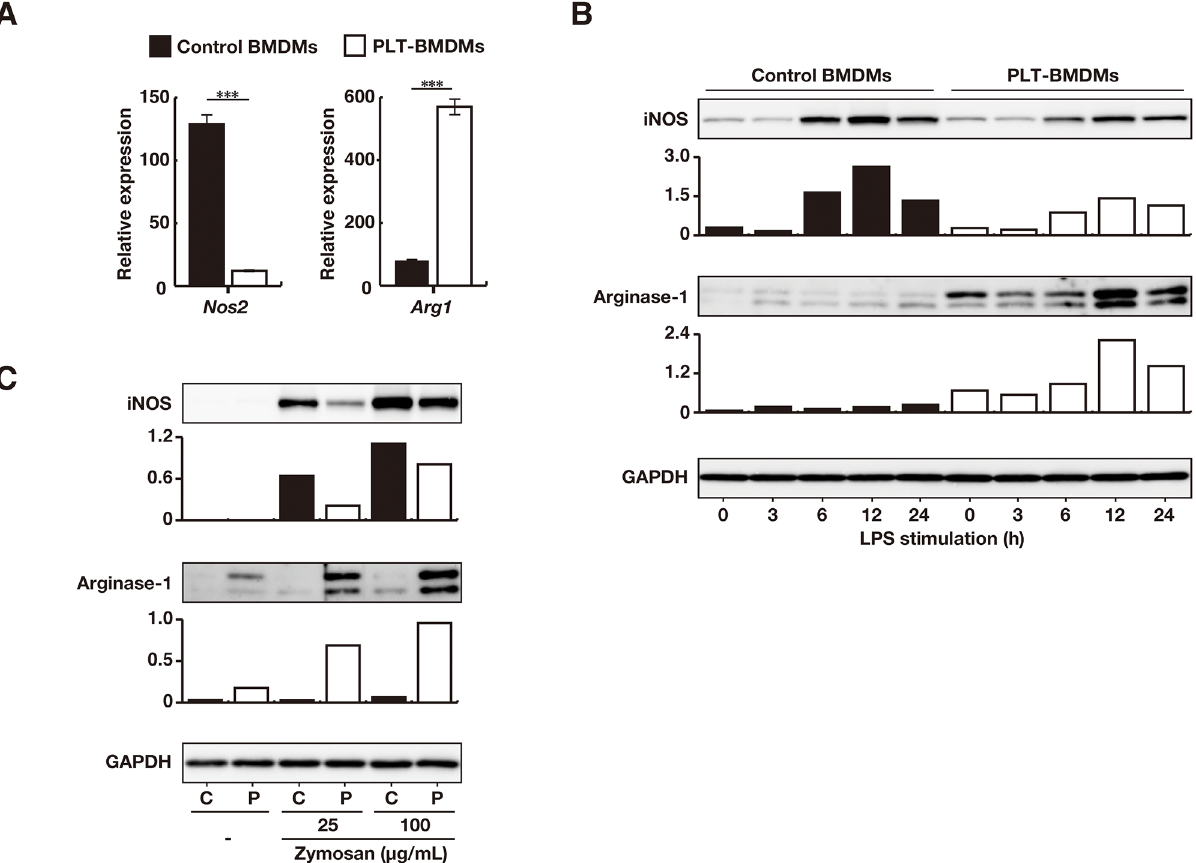
Fig 4. Expression of iNOS and arginase-1 in BMDMs after LPS stimulation. (A) PLT-BMDMs and control BMDMs (2.5 × 10 6 cells) were stimulated with LPS (50 ng/mL) for 24 h, and the gene expressions of Nos2 and Arg1 were analyzed by RT-qPCR with the relative standard curve method using Gapdh as an internal control. The gene expression is represented as the value relative to gene expression in the original BMDMs. Experiments were performed in quintuplicate and repeated four times. The data are presented as the mean ± SEM. *** p < 0.005 vs. control BMDMs. Representative results of the four experiments are shown. (B) PLT-BMDMs and control BMDMs (2.5 × 10 6 cells) were stimulated with LPS (50 ng/mL) for 0 – 24 h. Cells were then lysed in 1 × SDS sample buffer, and the cell lysates were subjected to western blotting analysis with antibodies against iNOS, arginase-1 or GAPDH. The relative intensity of each iNOS or arginase- 1 band after normalization to the levels for GAPDH is shown in the lower panel. Experiments were repeated four times, and representative results are shown. (C) PLT-BMDMs and control BMDMs (2.5 × 10 6 cells) were stimulated with zymosan (25 or 100 μ g/mL) for 12 h, and then cell lysates were subjected to western blotting analysis with antibodies against iNOS, arginase-1 or GAPDH. C , control BMDMs; P , PLT-BMDMs. The relative intensity of each iNOS or arginase-1 band after normalization to the levels for GAPDH is shown in the lower panel. Experiments were repeated four times, and representative results are shown.